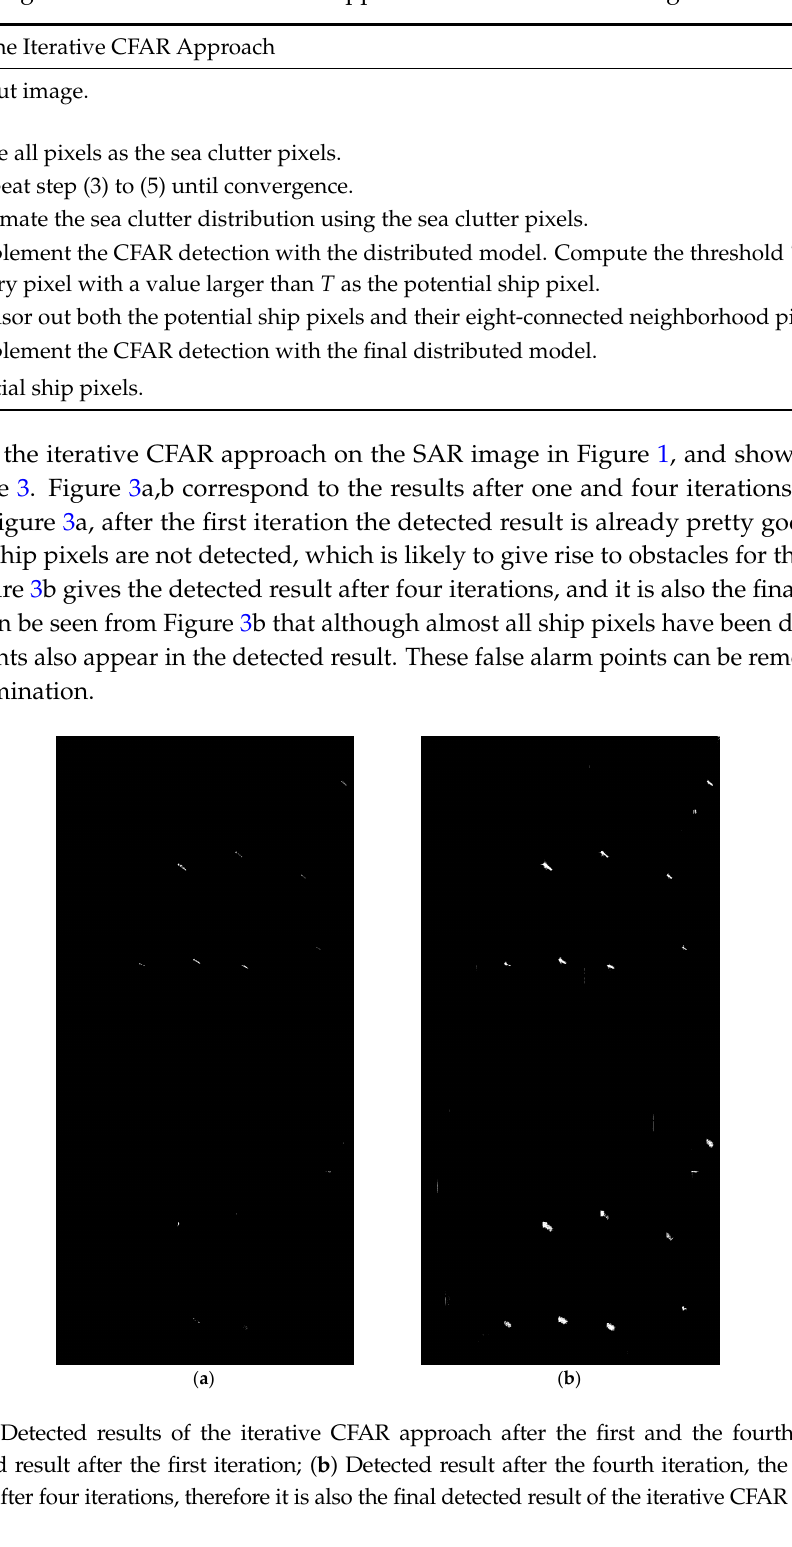
Algorithm 1 The Iterative CFAR Approach